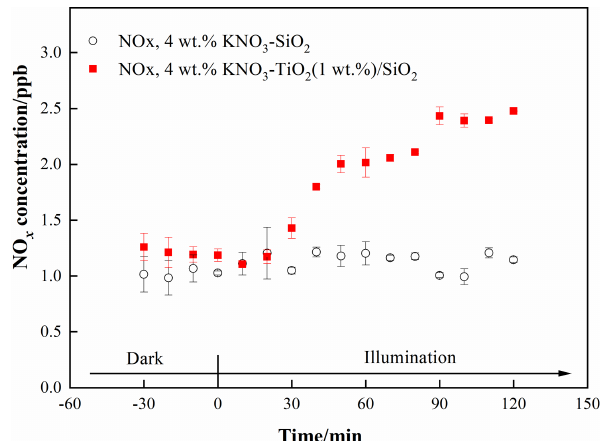
Figure 1. Effect of illumination on the release of NO x from 4wt% KNO 3 -SiO 2 and 4wt% KNO 3 –TiO 2 (1wt%) / SiO 2 at 293K and 0.8% of relative humidity. 365nm tube lamps were used during the illumination